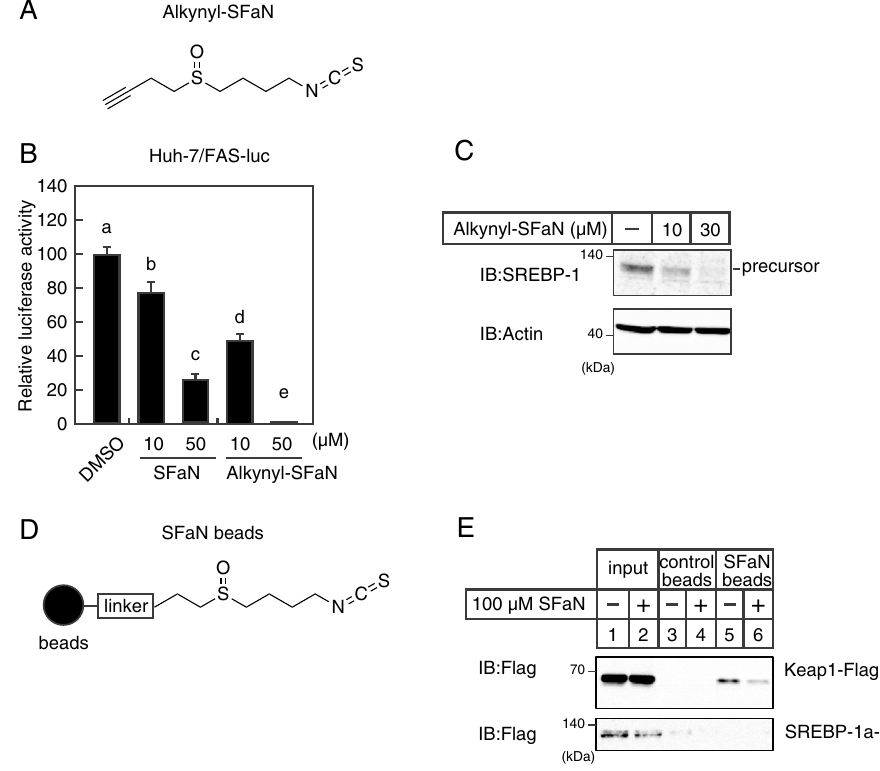
Figure 11. SFaN does not interact with SREBP-1a. ( A ) Structure of alkynyl-SFaN. ( B ) Huh-7/FAS cells were sterol-depleted by incubation in medium C for 16 h. The cells were then switched to medium C in the presence of the vehicle or the indicated concentrations of SFaN or alkynyl-SFaN. After incubation for 24 h, a luciferase assay was performed, and relative luciferase activity was obtained by activity normalization in the presence of the vehicle. All data are represented as the means ± S.E. (n = 3). Different superscript letters denote statistical significance (p < 0.05). ( C ) Huh-7 cells were sterol-depleted by incubation in medium D for 16 h. The cells were then shifted into medium D in the presence of the vehicle or the indicated concentrations of alkynyl- SFaN. After incubation for 3 h, whole-cell extracts underwent immunoblotting (IB) with anti-SREBP-1 (2A4), anti-SREBP-2, or anti-β-actin antibodies. ( D ) Structure of SFaN beads. ( E ) HEK293 cells were transfected with pCMV-SREBP-1a-(2–1147)-3 × FLAG and pCMV-Keap1-3 × FLAG and cultured in medium B for 24 h. Whole- cell extracts underwent pull-down experiments with SFaN beads with or without the addition of 100 μM SFaN and were then subjected to immunoblotting (IB) using an anti-FLAG antibody. Full-length images are presented in Supplementary Fig.